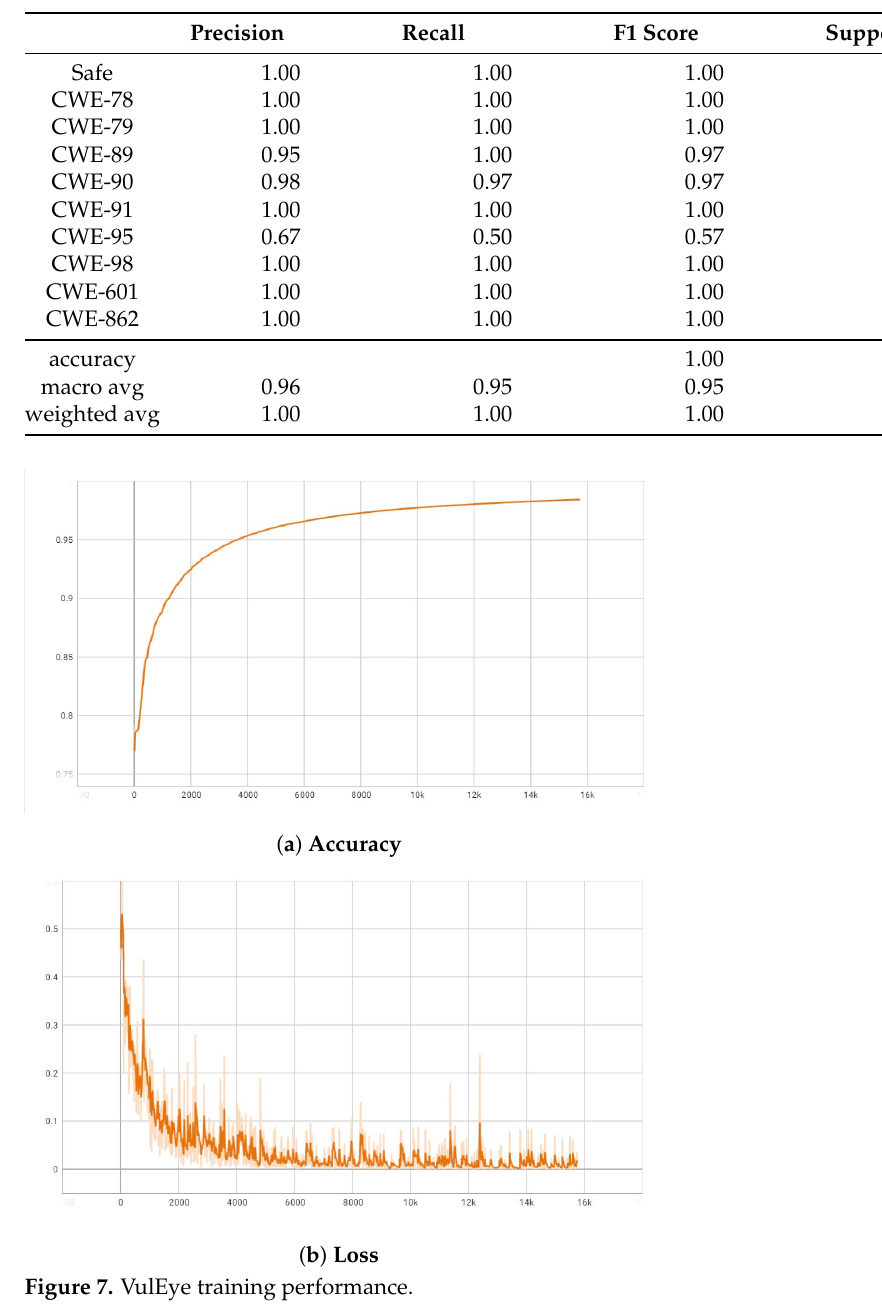
Table 8. Multi-classes Classification report of VulEye.